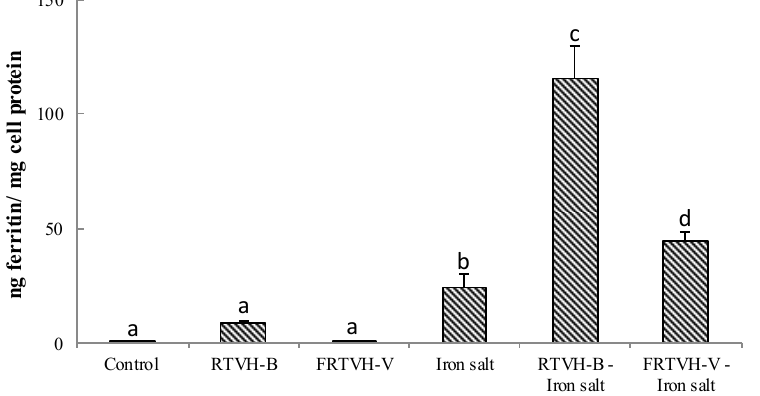
Figure 6. Iron bioavailability (ng ferritin/mg cell protein) of cells treated with iron salt (FeSO 4 .7H 2 O) in free and complexed forms. Control: cells treated with DMEM. Values are expressed as means ± standard deviation ( n = 4). Different superscript letters (a–d) denote statistically significant differences among treatments ( p < 0.05).